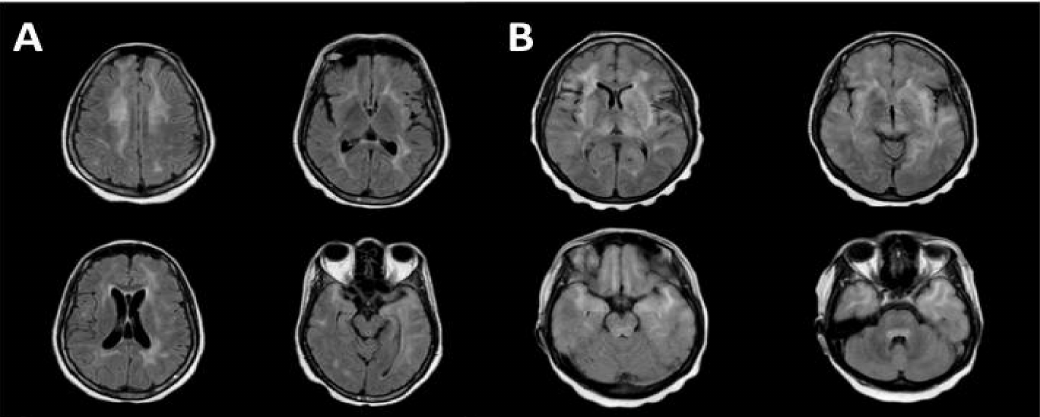
Figure 4. MRI brain images demonstrating the characteristic features in CD8E. ( A ) bilateral periven- tricular deep white matter changes with high signal involving both temporal lobes on axial T2 FLAIR sequences. ( B ) axial T2 FLAIR sequences revealing diffuse non-restricting T2 hyperintensities throughout the white matter involving the pons, temporal poles, insulae and periventricular white matter (with permission from Kerr et al.